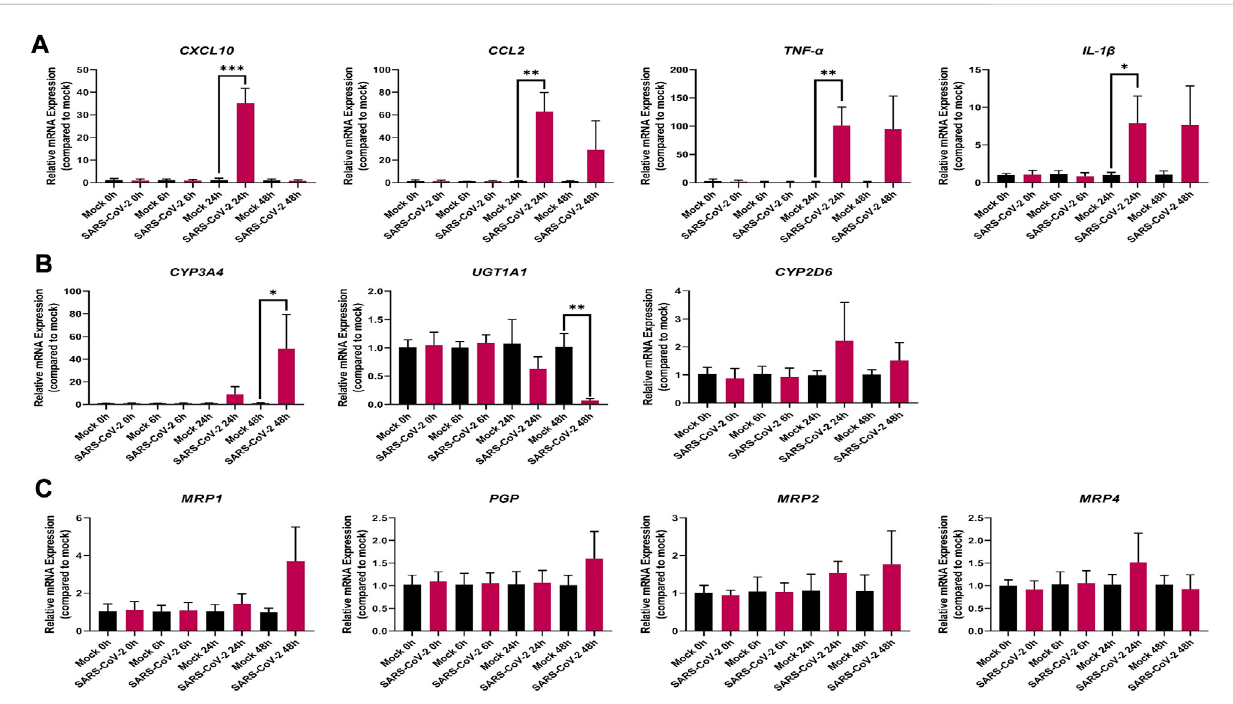
FIGURE 2 EffectofSARS-CoV-2infectiononthemRNAexpressionofselected (A) in fl ammatorymarkers; (B) drugmetabolizingenzymes;and (C) membrane- associated drug transporters in Vero E6 cells. Relative mRNA expression was determined using qRT-PCR with normalization to the housekeeping gene andthemock.Resultsareexpressedasmean±SDfrom3independentexperiments,andunpaired t -testwasusedtodeterminesigni fi cantdifferences(*, p < 0.05; **, p < 0.01; ***, p <